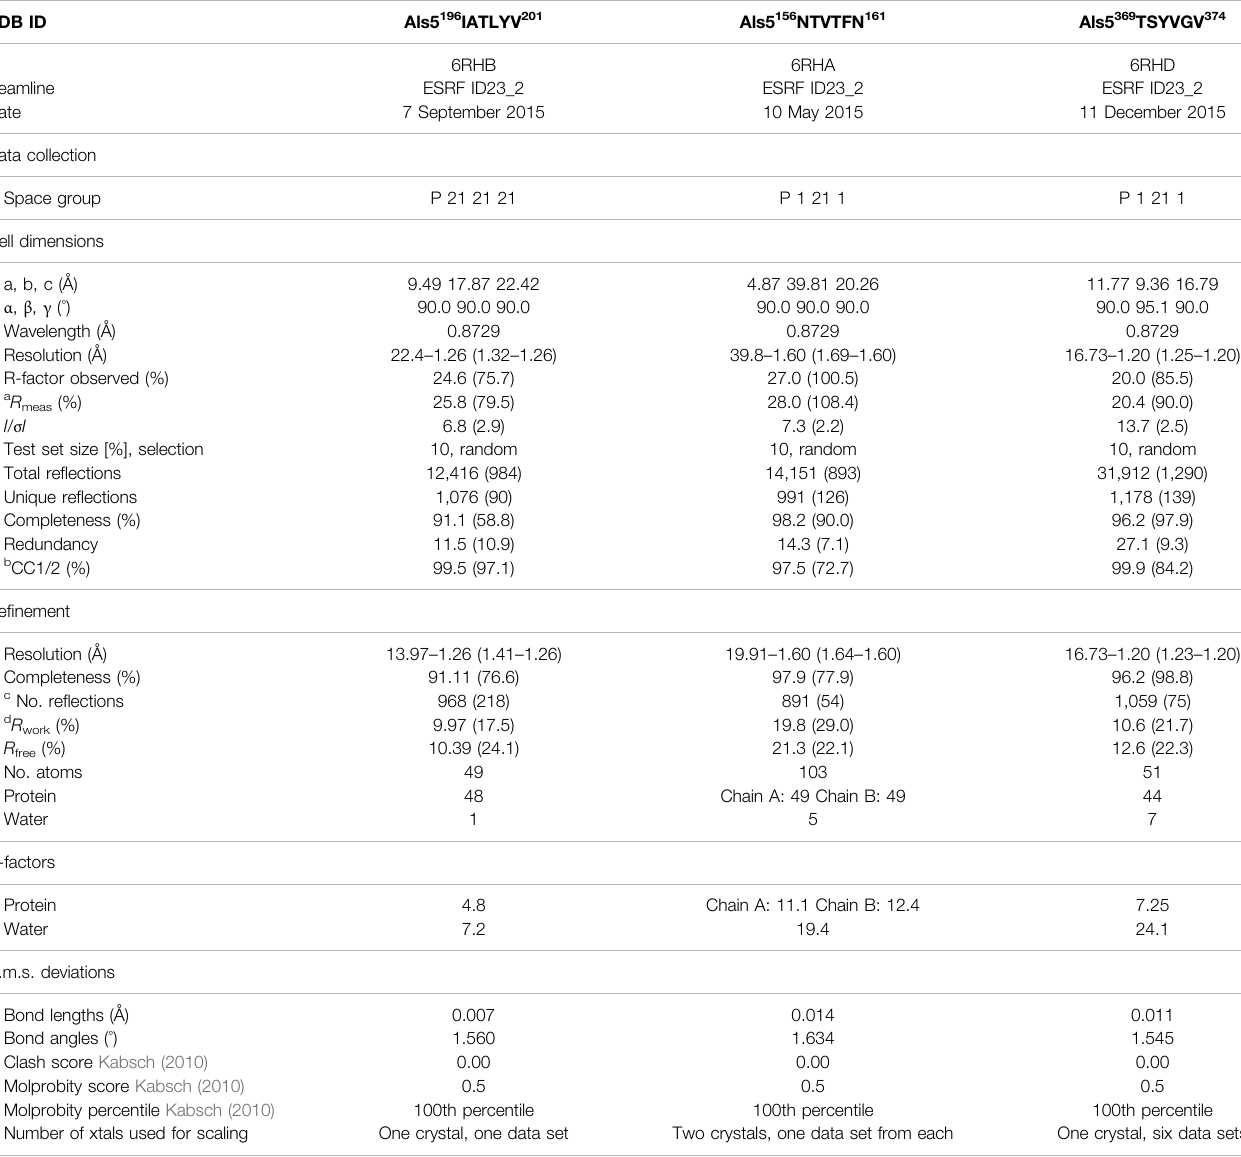
TABLE 1 | Data collection and re fi nement statistics.